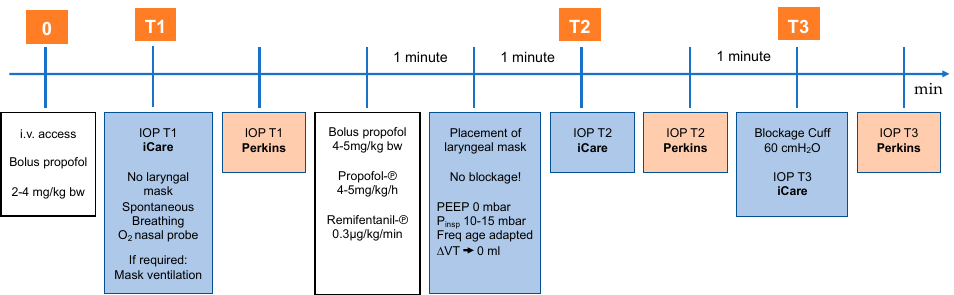
Figure 1. Sequence of measurements and procedures within EyeBIS study. Adapted from Pirlich, N.; Grehn, F.; Mohnke, K.; Maucher, K.; Schuster, A.; Wittenmeier, E.; Schmidtmann, I.; Hoffmann, E.M. Anaesthetic Protocol for Paediatric Glaucoma Examinations: The Prospective EyeBIS Study Protocol. BMJ Open 2021, 11, e045906 [25]. Abbreviation: i.v.: intravenous; bw: bodyweight; IOP: intraocular pressure; PEEP: Positive End-Expiratory Pressure; Pinsp: inspiratory pressure; Freq: frequency; VT: tidal volume.